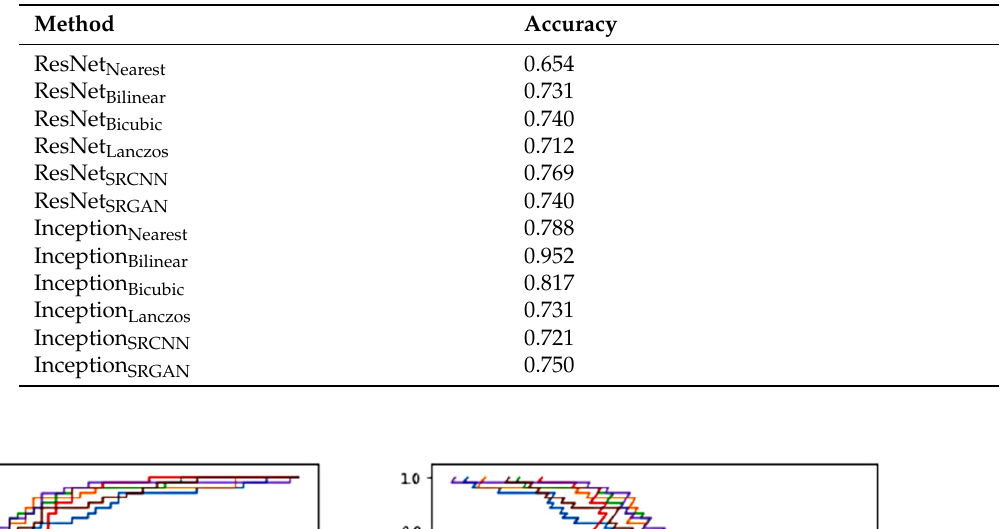
Table 8. Overall test accuracy obtained for each model.